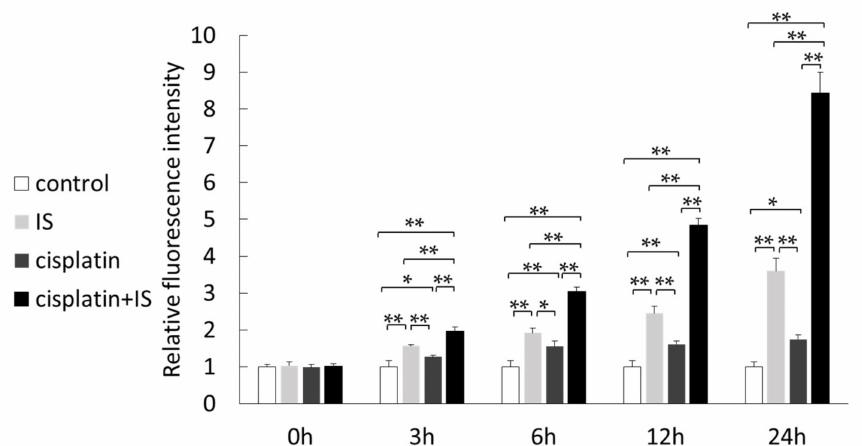
Figure 6. Effect of treatment with cisplatin and/or IS on the reactive oxygen species (ROS) level in HK-2 cells: the data were corrected with the control for each time point. Each column represents the mean ± S.D. of triplicate samples. * p < 0.05; ** p <